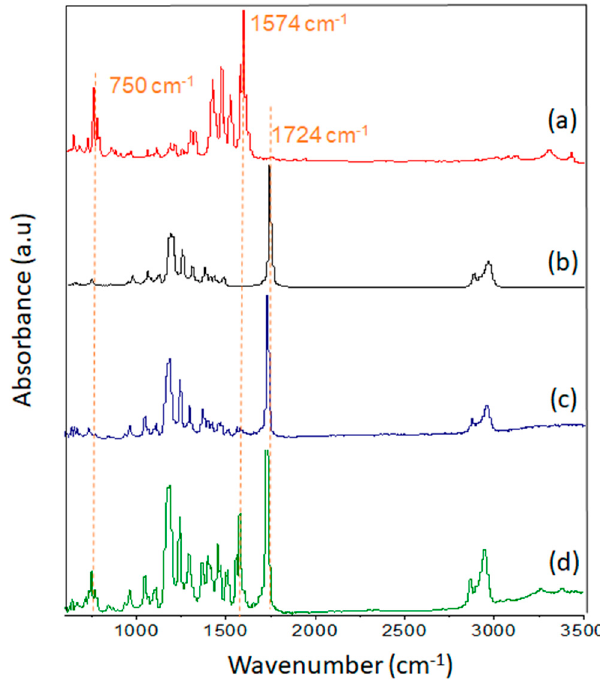
Figure 3. Infrared spectrum of diclofenac sodium salt ( a ), electrospun pure PCL ( b ), PCL/12.5%DSS ( c ), and PCL/25%DSS ( d ) fibrous mats.